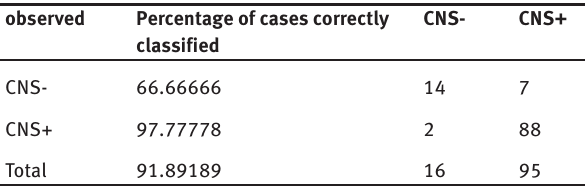
Table 7: Classification matrix for model with discriminating variables